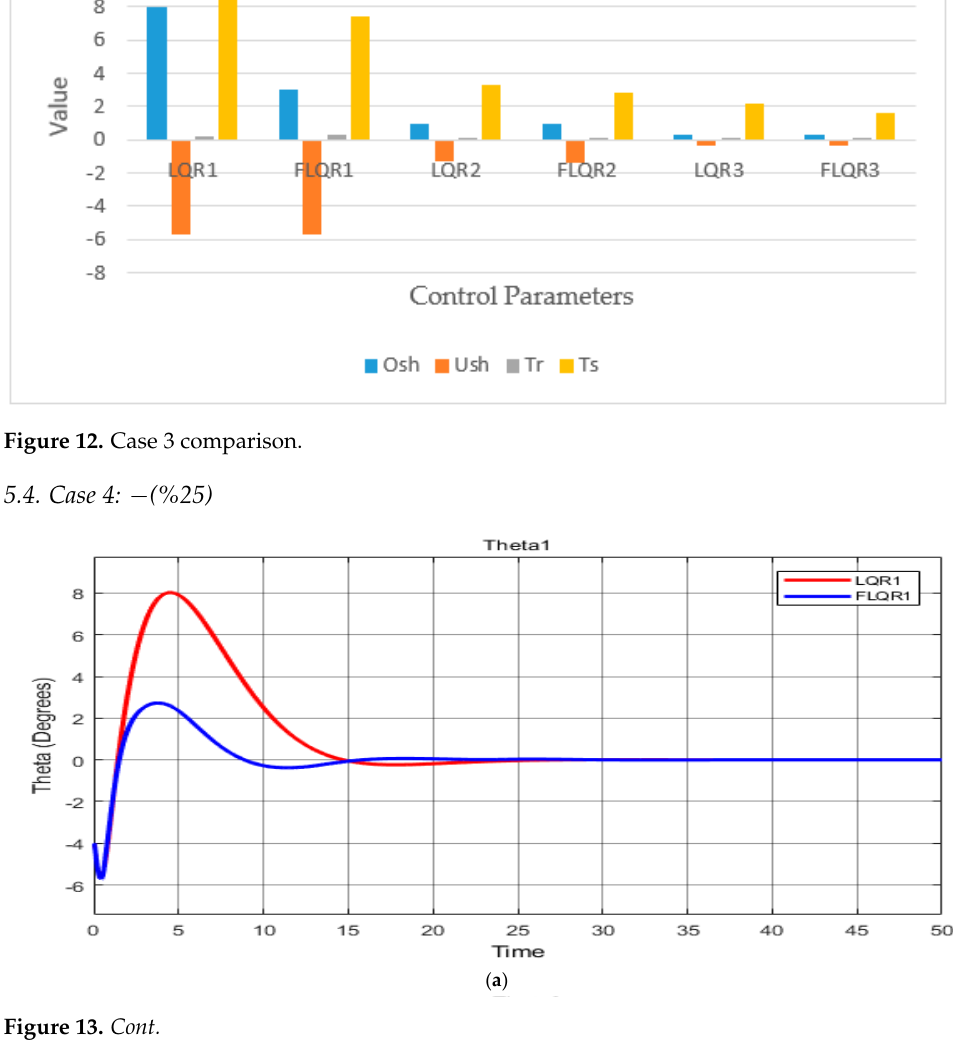
( b ) ( c ) Figure 13. ( a ) The system response for 1st link of Robogymnast in Case 4 (T1); ( b ) The system response for central link of Robogymnast in Case 4 (T2); ( c ) The system response for link-3 of Robogymnast in Case 4 (T3).